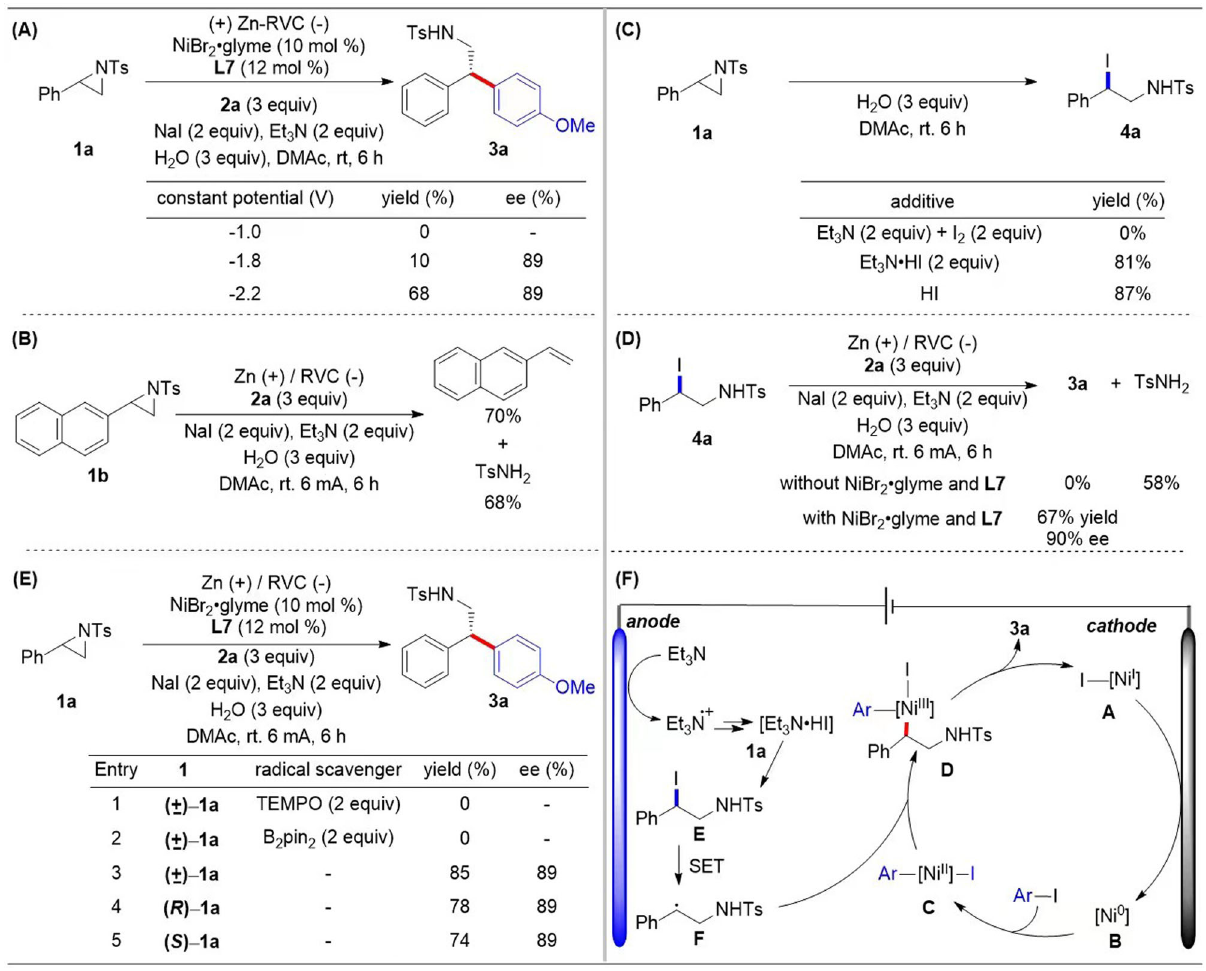
Fig. 5 | Mechanistic studies. A Constant potential electrolysis. B Control experiment. C Ring-opening experiments of aziridine. D Transformation of the proposed intermediate. E Radical scavenging experiments and stereochemical studies. F Proposed